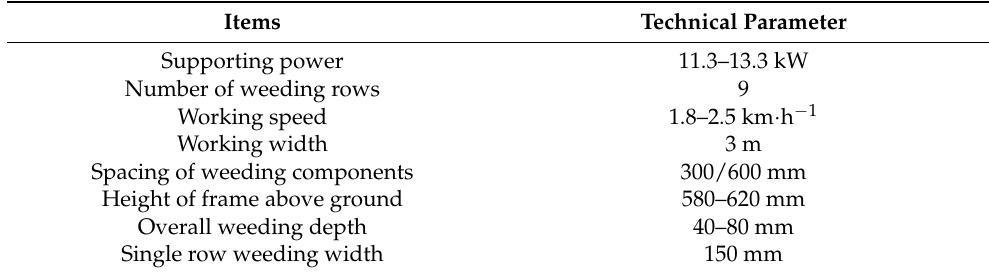
Table 1. Performance parameter table of reciprocating inter-row paddy weeding machine for strip- seeded rice.